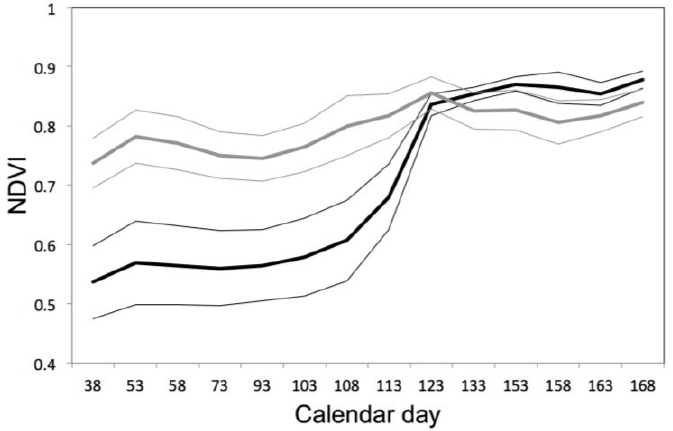
Figure 5. NDVI time series for nestboxes characterized by deciduous-only ( n = 110, in black) and evergreen-only ( n = 10, in grey) oak environments in a 50 m radius. Averages and standard deviations are presented as thick and thin lines,